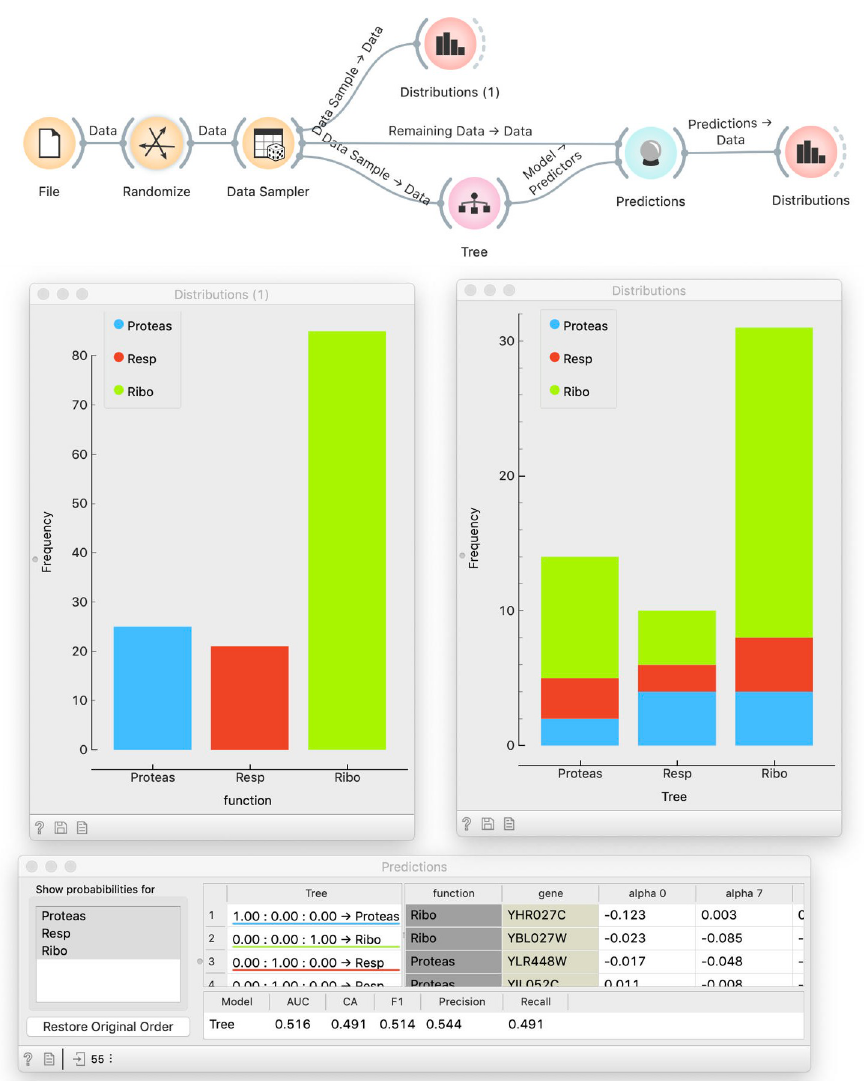
Fig 5. Testing a model on a separate data set. The Random Sample widget splits the data into two subsets, one for fitting and one for testing. Distribution of predictions by the model (right-hand histogram) roughly match the distribution of actual classes (left-hand side), but the actual class no longer matches the